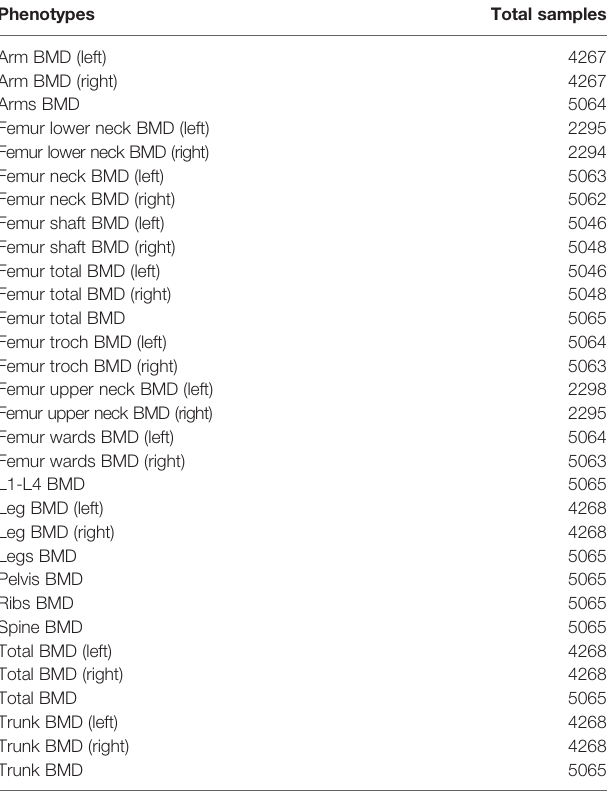
TABLE 1 | The number of samples for the BMD of different sites from the UK